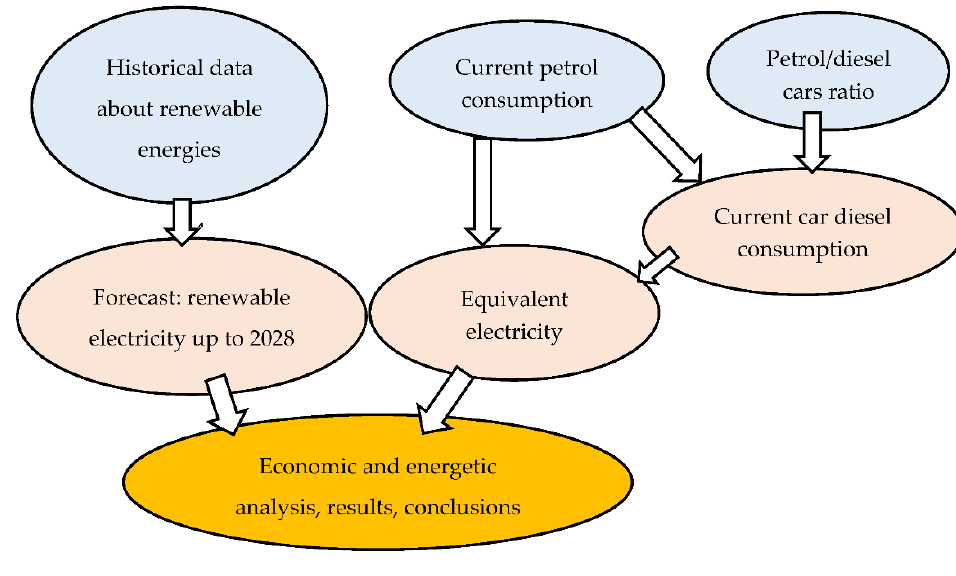
Figure 4. The research